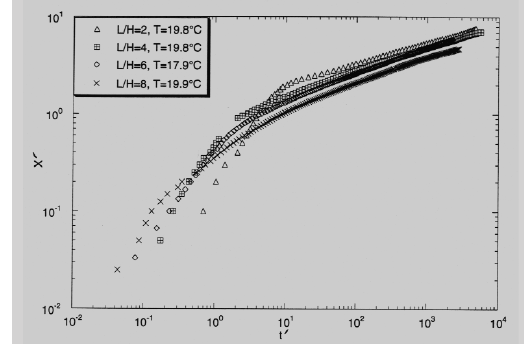
Figure 8 (left): The (non dimensional) front wave evolution for c = 50%. Figure 9 (right): Typical rheogram of the sus- pension for c = 60%. Figure 10 (bottom): Final picture of the suspen- sion flow for c =